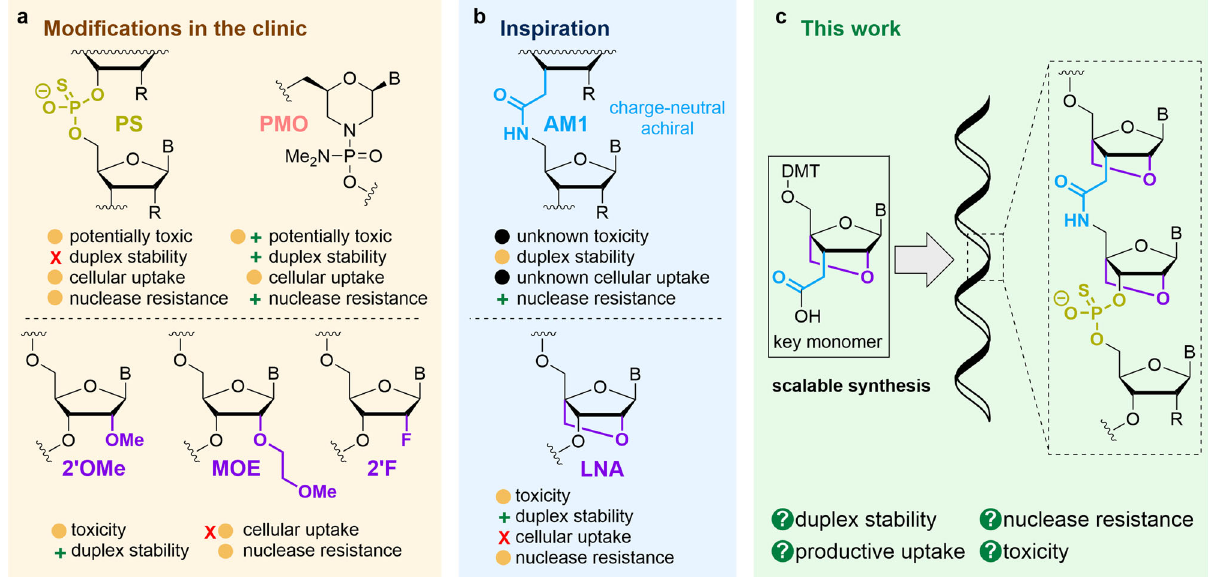
Fig. 1 Therapeutic oligonucleotide modi fi cations and our strategy for combining these. a Existing therapeutic oligonucleotide modi fi cations and their properties. Traf fi c light coding system: green plus = good; amber circle = intermediate; red cross = poor. b Oligonucleotide modi fi cations that have not yet reached the clinic c Development of a new antisense backbone chemistry with improved target af fi nity and cellular activity. The LNA-amide linkage is achiral and can be prepared by solid-phase synthesis methods that are high yielding with the potential to be automated. PS phosphorothioate,